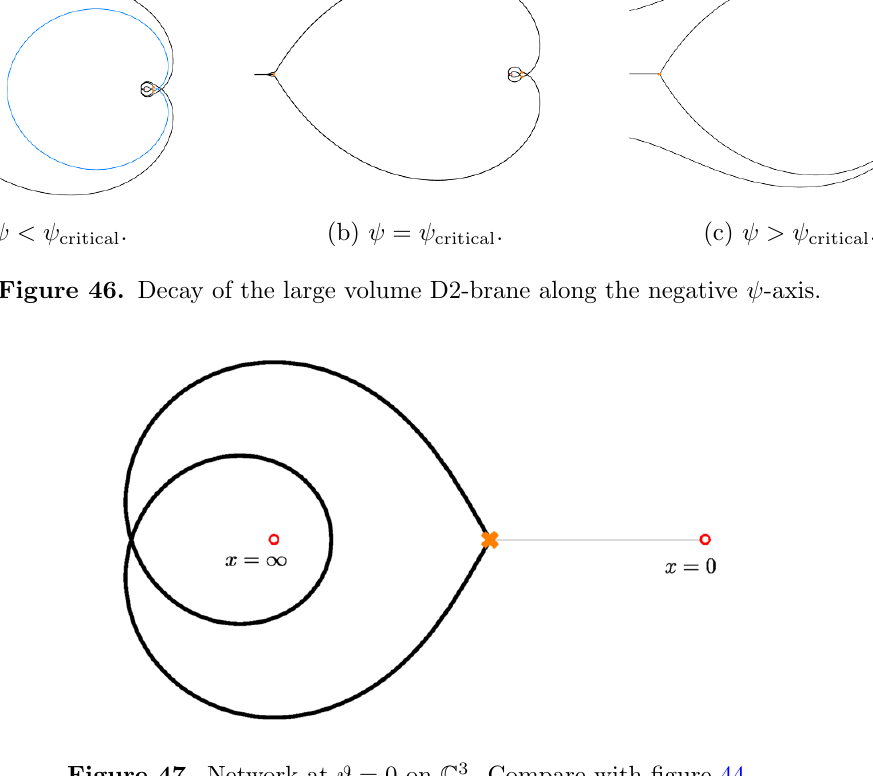
Figure 47. Network at # = 0 on C 3 . Compare with (cid:12)gure